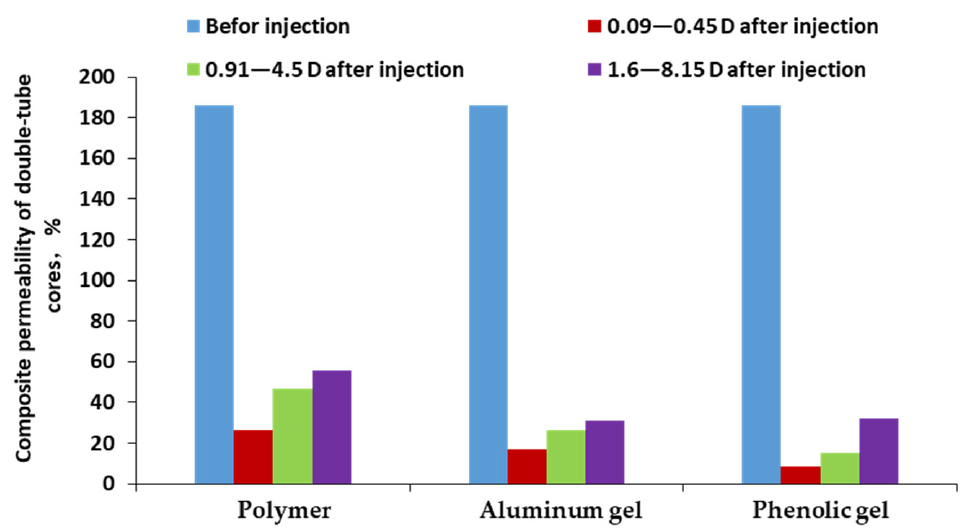
Figure 11. Comparison of composite permeability variation of polymer and gel systems .